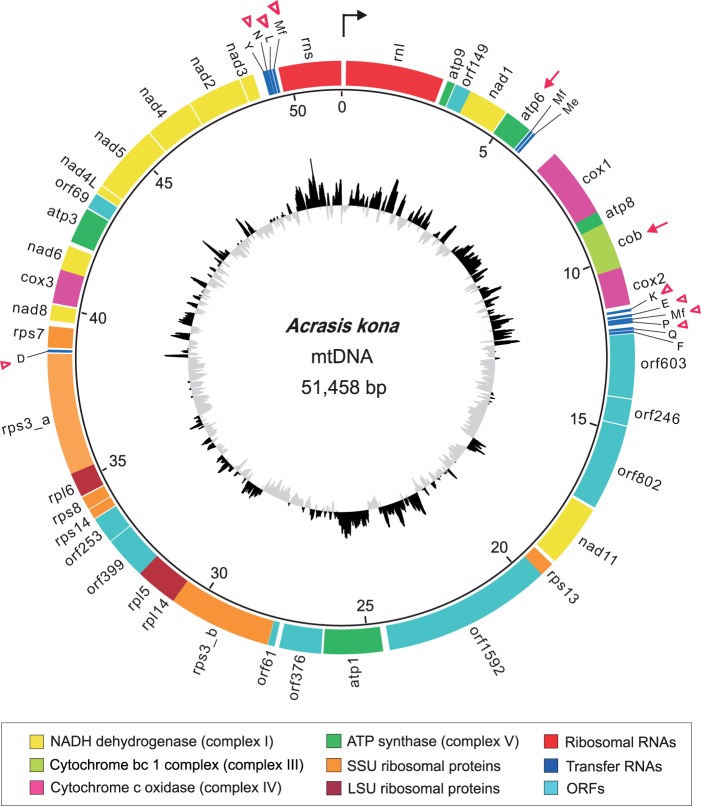
The mitochondrial genome of Acrasis kona. A circular map of the A. kona mtDNA is shown, drawn to scale as indicated by the inner circle and with coordinates in kilobases. The outermost track shows predicted genes, color-coded by functional category as indicated in the box below the map. The innermost circle shows GC content above (black) or below (gray) the genome average. Protein-coding genes with identified C-to-U type RNA editing are indicated with arrows. tRNA genes with predicted mismatches at the first three positions of the acceptor stem are indicated with triangles.